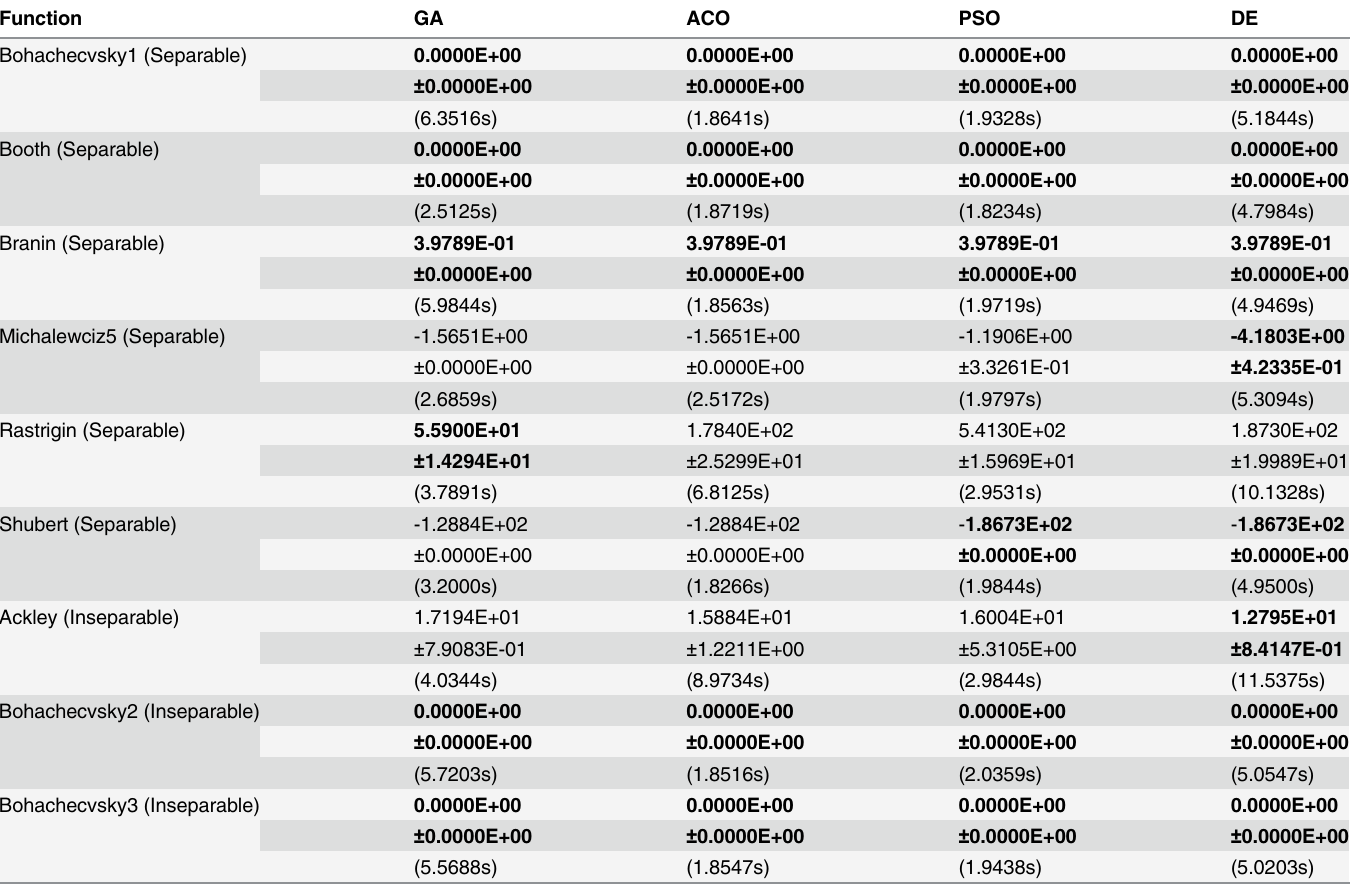
Table 5. Benchmark Functions Comparison of mean error (Mean ± SD) and time (Seconds) on Several Optimization Techniques. Function GA ACO PSO DE Bohachecvsky1 (Separable)